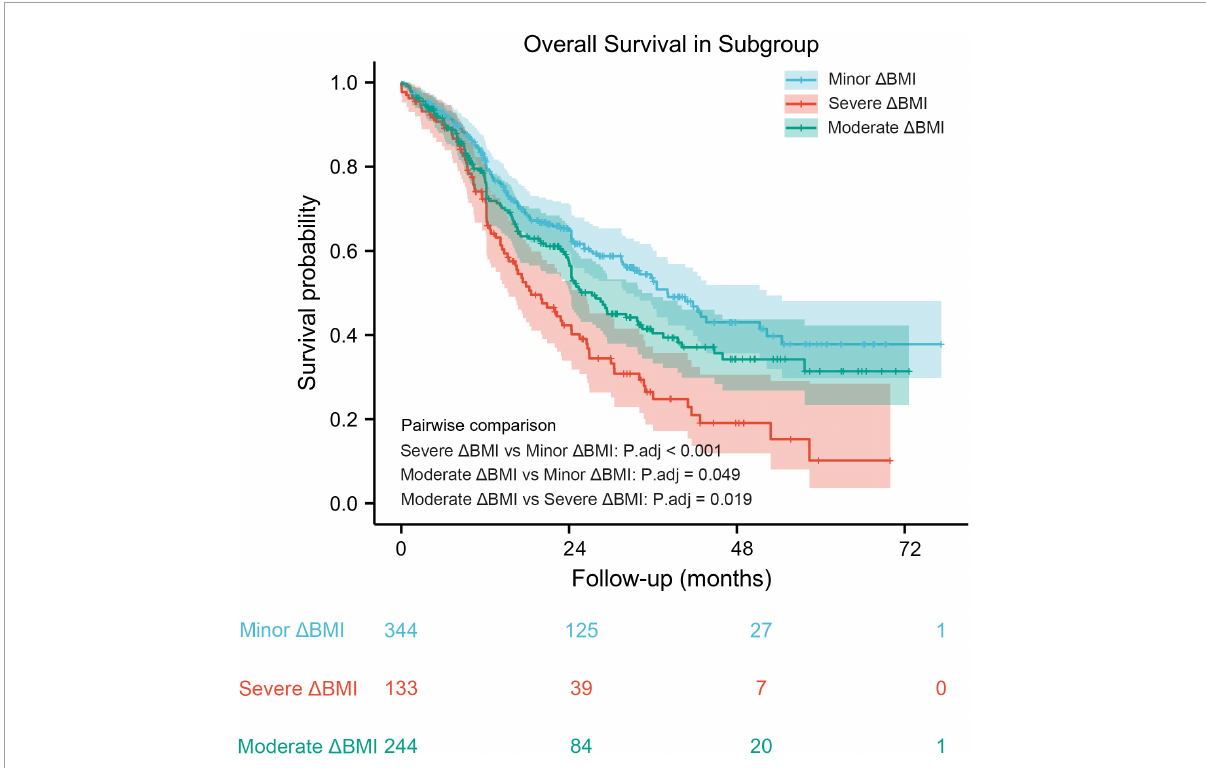
FIGURE2 A preoperative body mass index changes-based nomogram for predicting prognosis after curative resection of esophageal squamous cell carcinoma.